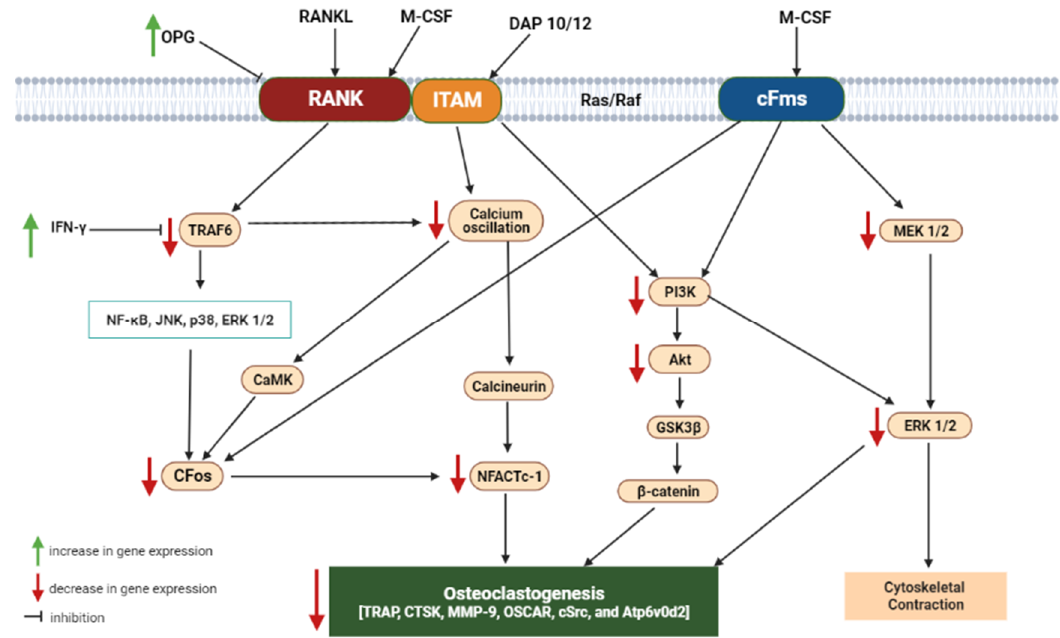
Figure 4. Summary of signaling pathways through which natural products exert their osteopro- tective properties, in addition to the Keap-1/Nrf2 signaling pathway. OPG—osteoprotegerin; NFATc-